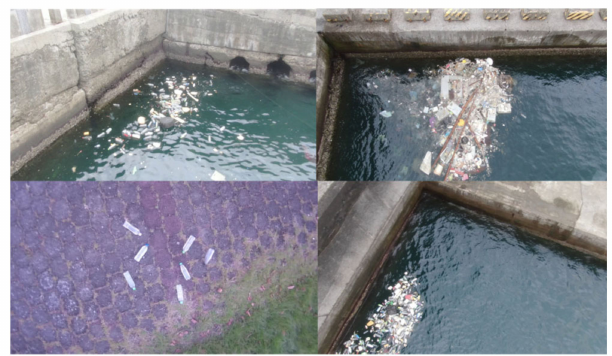
Figure 1. HAIDA trash